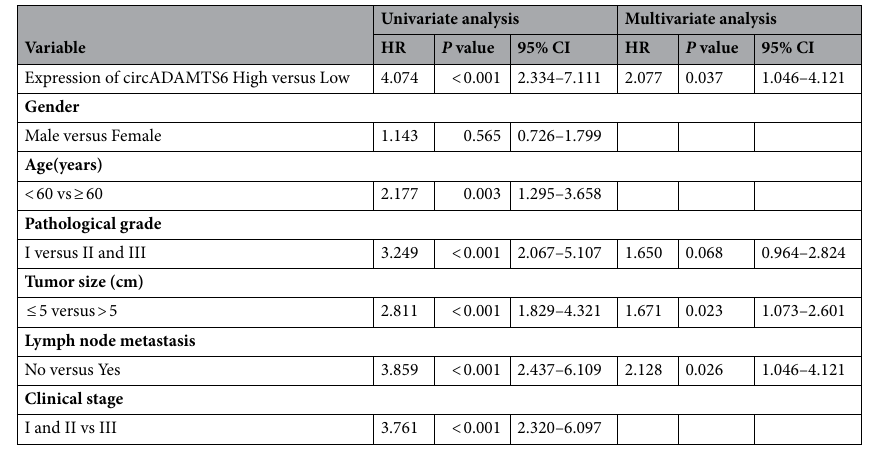
Table 1. Univariate and multivariable analyses of prognostic factors in ESCC for overall